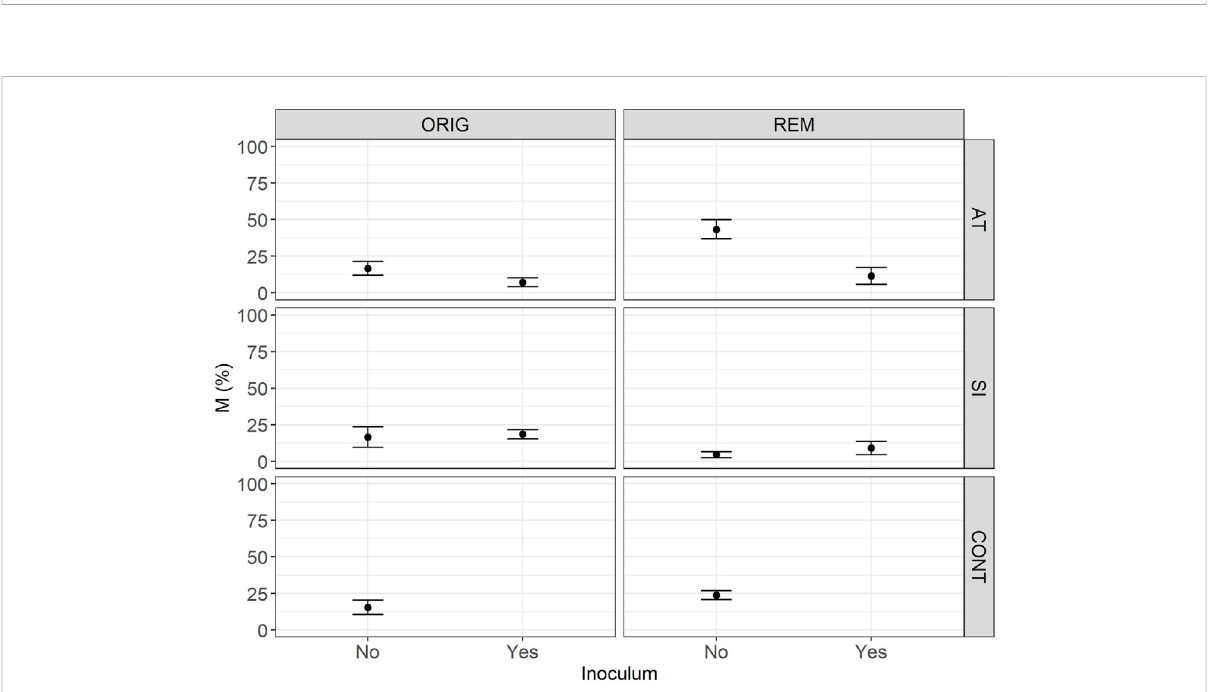
FIGURE 3 Meanintensity(M)ofmycorrhizalcolonisationintherootsystem(M)in Loliumperenne L.inAustrian(AT),Slovenian(SI)andcontrolsoil(CONT), before (ORIG) and after remediation (REM). Root sampling on 17 November 2017. The addition of indigenous inoculum (rhizosphere soil and roots from a grassland) is marked yes/no. Shown are the measured values of mean and